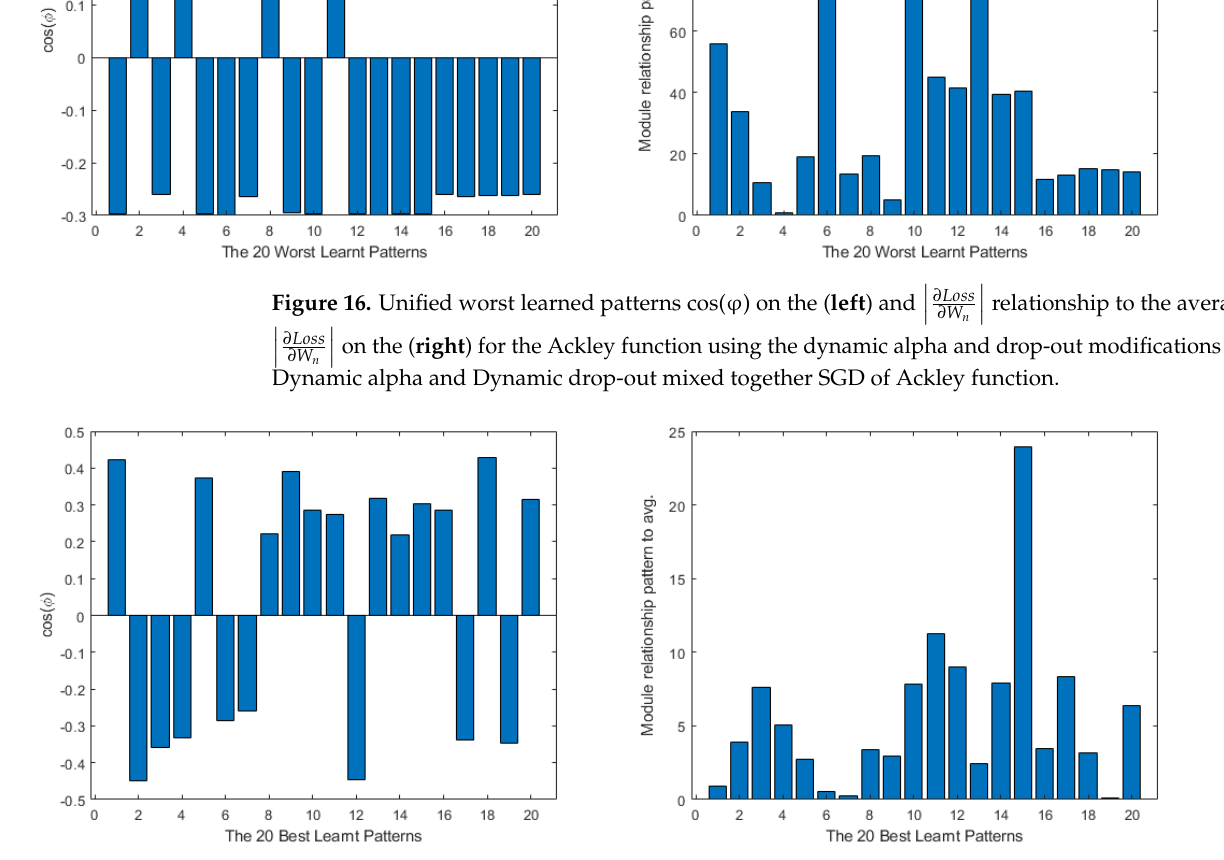
(cid:12) (cid:12) 𝜕𝐿𝑜𝑠𝑠 ∂ Loss (cid:12) (cid:12) | relationship to the average (cid:12) (cid:12) relationship to the average ∂ W n 𝜕𝑊 𝑛